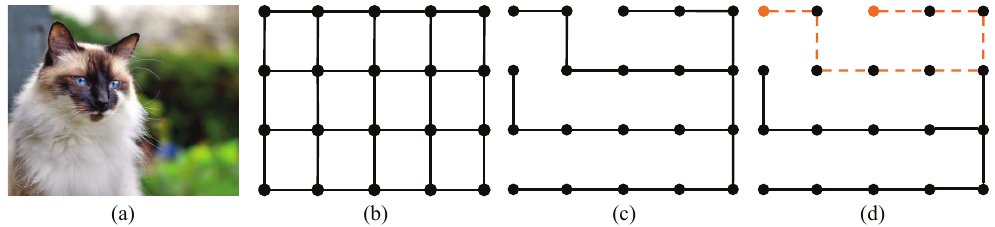
Figure 2. A simple illustration of the MST for an image. ( a ) is an image. ( b ) is a 4-connected, undirected graph built by ( a ). ( c ) is the MST generated from ( b ). ( d ) shows the path on MST between two target